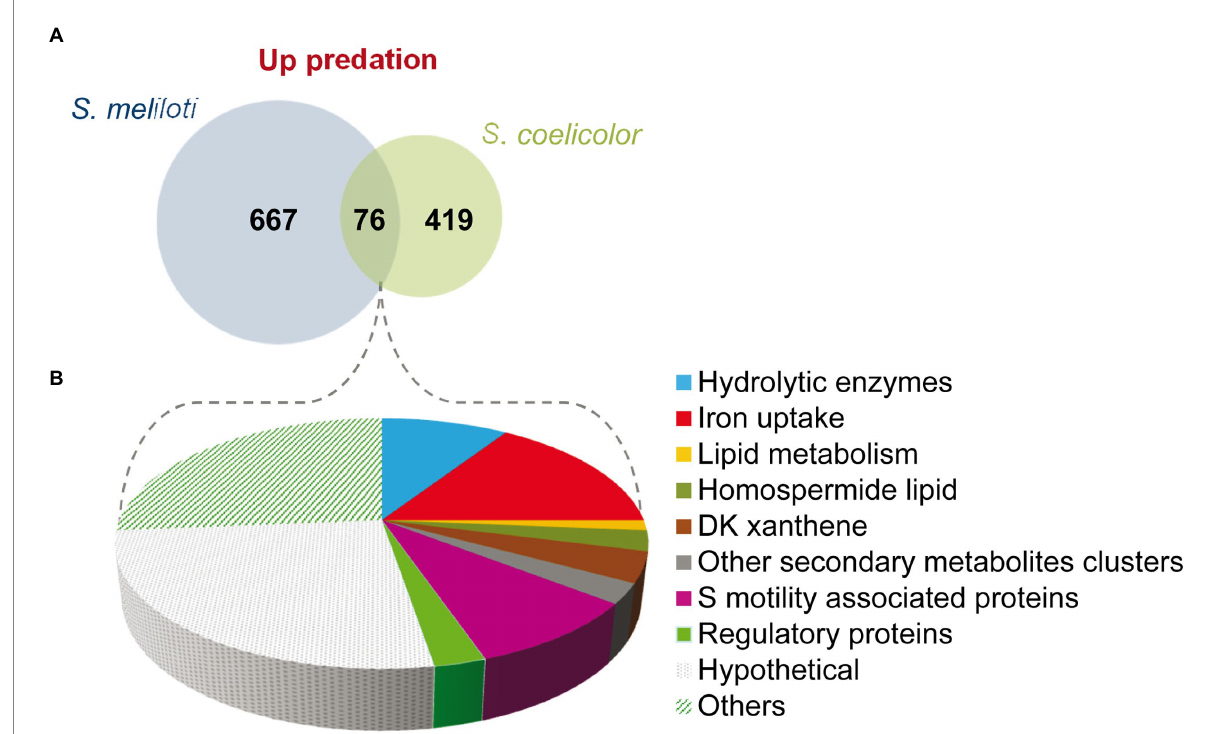
FIGURE 5 Comparison of the predatosomes of M. xanthus on S. meliloti and S. coelicolor. (A) Venn diagram of upregulated genes with Log2 Fold Change>0 and p adj<0.05. (B) Proportion of different pathways and protein functions of the 76 common